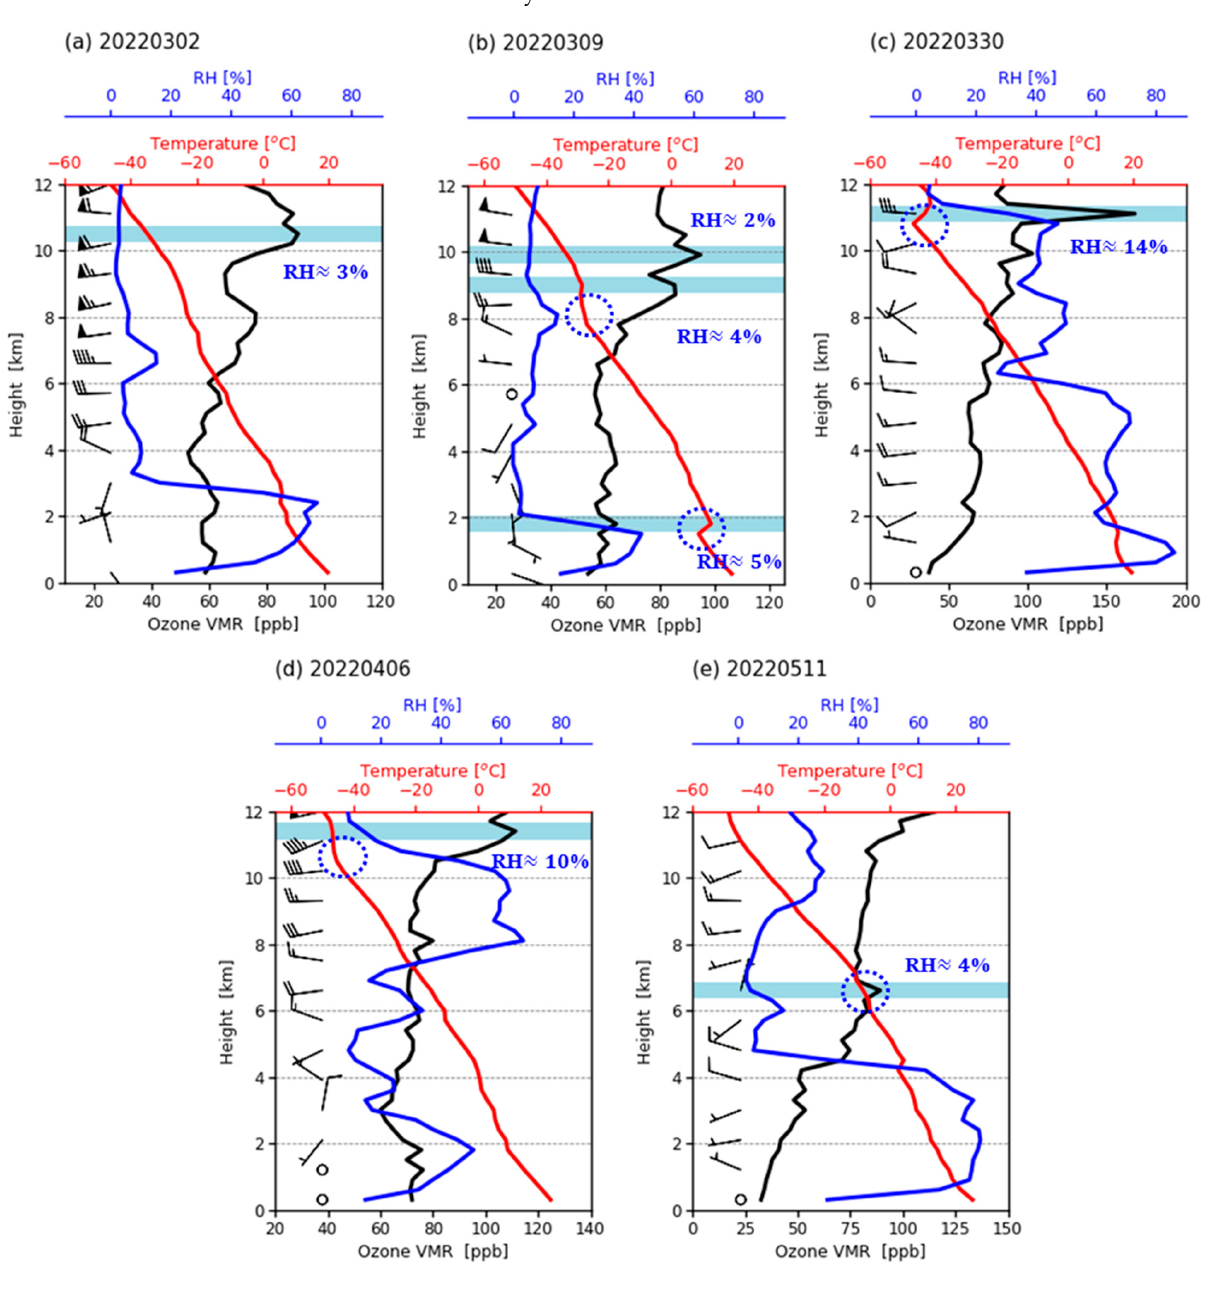
Figure 8. Same as Figure 7, but for the spring.